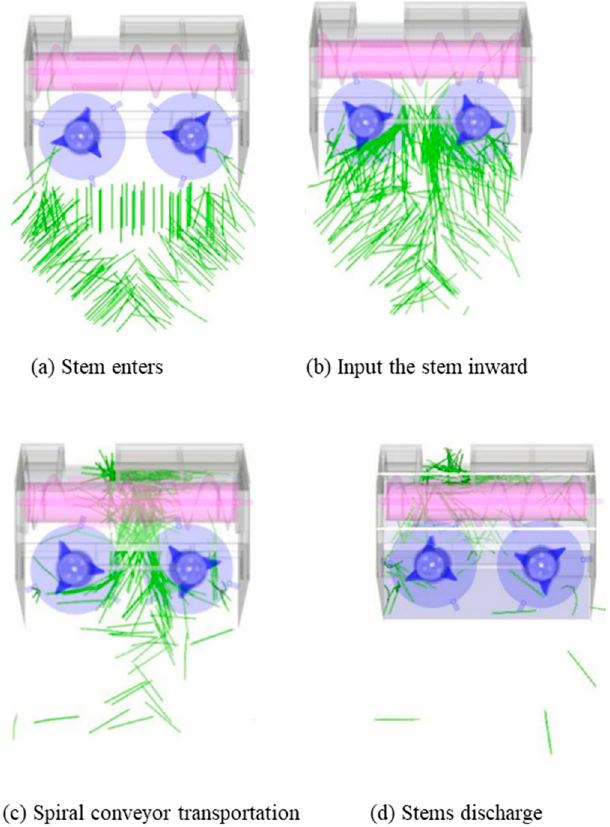
Figure 15. Rocky virtual feed operation status. ( a ) Stem enters; ( b ) Input the stem inward; ( c ) Spiral conveyor transportation; ( d ) Stems discharge.